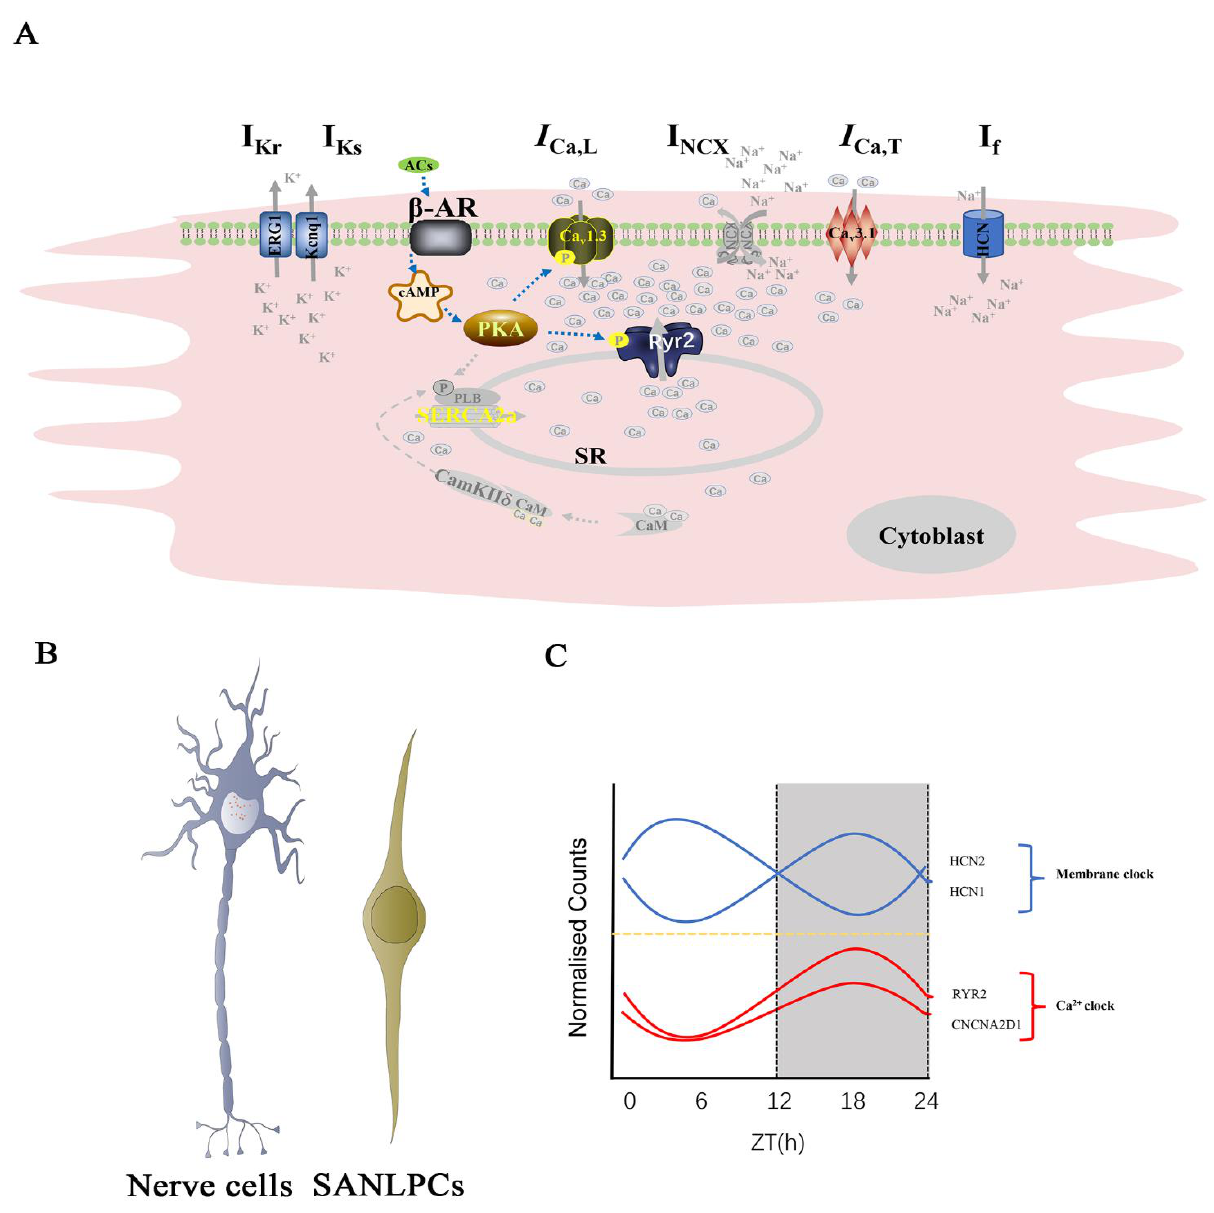
Figure 4. Physiological properties of the sinoatrial node. ( A ) The M-clock includes hyperpolarization-activated cyclic-nucleotide-gated cation channels (I f ), T-type Ca 2+ channels (I Ca,T ), Na + /Ca 2+ ex- changer proteins (NCX, I NCX ), L-type Ca 2+ channels (I Ca,L ), and rapid and slow delayed rectifier K+ channels (I kr and I ks ). The calcium clock includes the sarco-/endoplasmic reticulum Ca 2+ ATPases (SERCA) modulated by cardiac phospholamban (PLB) and ryanodine receptors (RyR2) located in the sarcoplasmic reticulum membrane. Both the M- and calcium clocks are regulated by the autonomic nervous system through β -adrenergic and muscarinic stimulations, which modulate the activity of protein kinases (cAMP-dependent protein kinase (PKA) and calcium/calmodulin-dependent protein kinase type II (CAMKII)) that phosphorylate multiple proteins in the system. ( B ) Whether the SANLPCs are nerve cells. ( C ) M-clock and Ca 2+ clock exhibit circadian rhythms.